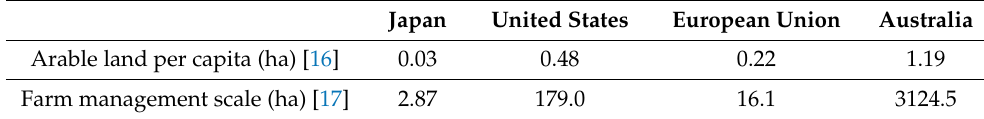
Table 1. Comparison of arable land and farm management scale in several